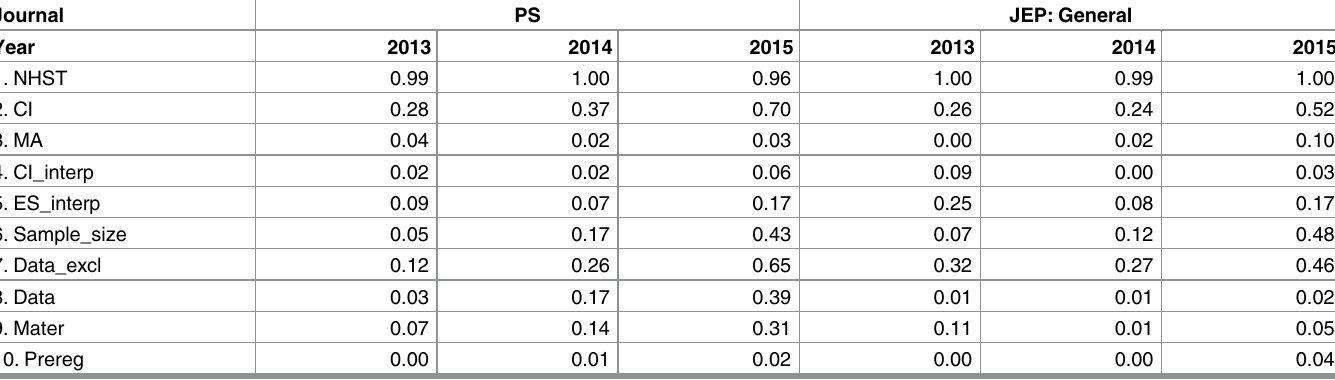
Table 2. Proportions of papers in Psychological Science and the Journal of Experimental Psychology : General from the 2013to the 2015, for each of the ten